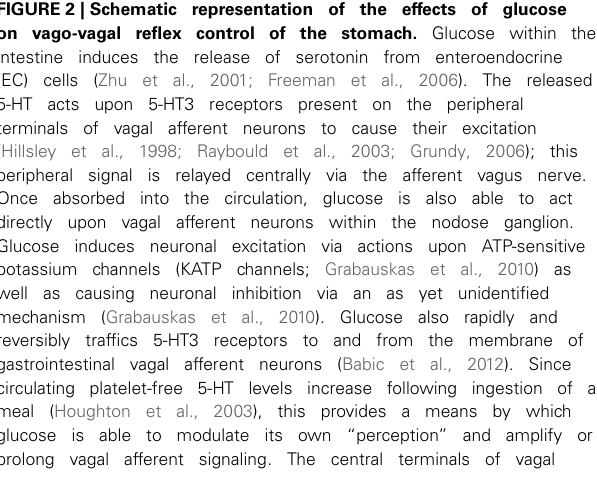
afferent neurons enter the brainstem via the tractus solitarius and terminate on NTS neurons using predominantly glutamate as a neurotransmitter (Andresen and Yang, 1990; Andresen and Kunze, 1994). Glucose is also able to modulate the release of glutamate from the central terminals of vagal afferents by actions that involve 5-HT3 receptors (Wan and Browning, 2008a,b). Glucose can also activate NTS neurons via actions on KATP channels and increase synaptic transmission to gastric-projecting DMV neurons (Adachi et al., 1984, 1995; Ferreira et al., 2001). Glucose can also modulate the activity of DMV neurons directly (Trapp et al., 1994; Karschin et al., 1998; Balfour et al., 2006; Balfour and Trapp, 2007). The result of these central and peripheral actions of glucose is gastric relaxation and delayed gastric emptying (Schvarcz et al., 1997; Raymer et al., 2000; Rayner et al., 2001). The vagal efferent pathway involved in this gastric relaxation and delayed gastric emptying is still controversial. Peripheral actions of glucose appear to involve activation of a non-adrenergic, non-cholinergic pathway (Zhou et al., 2008) whereas central glucose appears to involve inhibition of the tonically active cholinergic pathway (Ferreira et al., 2001; Shi et al., 2003,